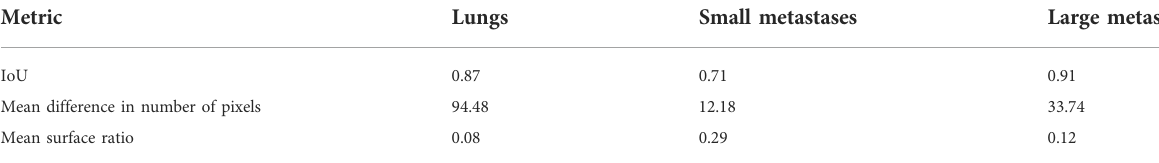
TABLE 3 Inter-observer differences. Measured Inter-observer differences in manual annotation of the test set. Reproducibility between two annotationsismeasuredbytheIoU;annotationdifferenceismeasuredbythecountofdifferingpixelsandthesurfaceratio,withatotalpixelsper slice of